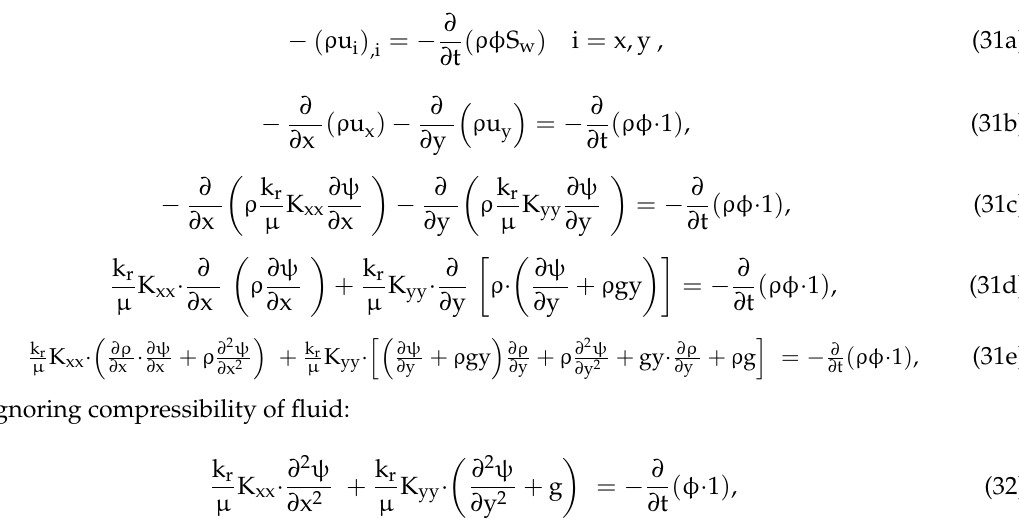
Figure 9. Simulated relative permeability distribution after 5000 s.